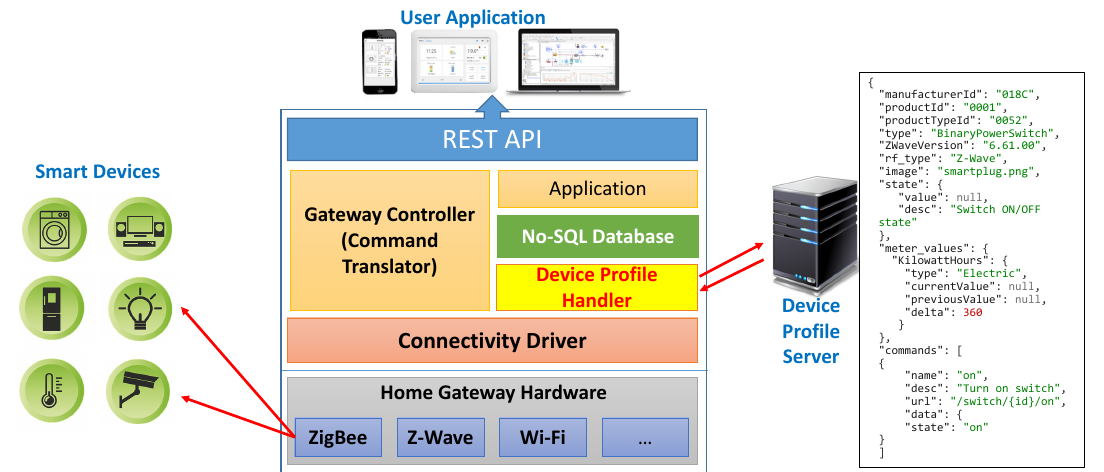
Figure 2. Software architecture of the smart home